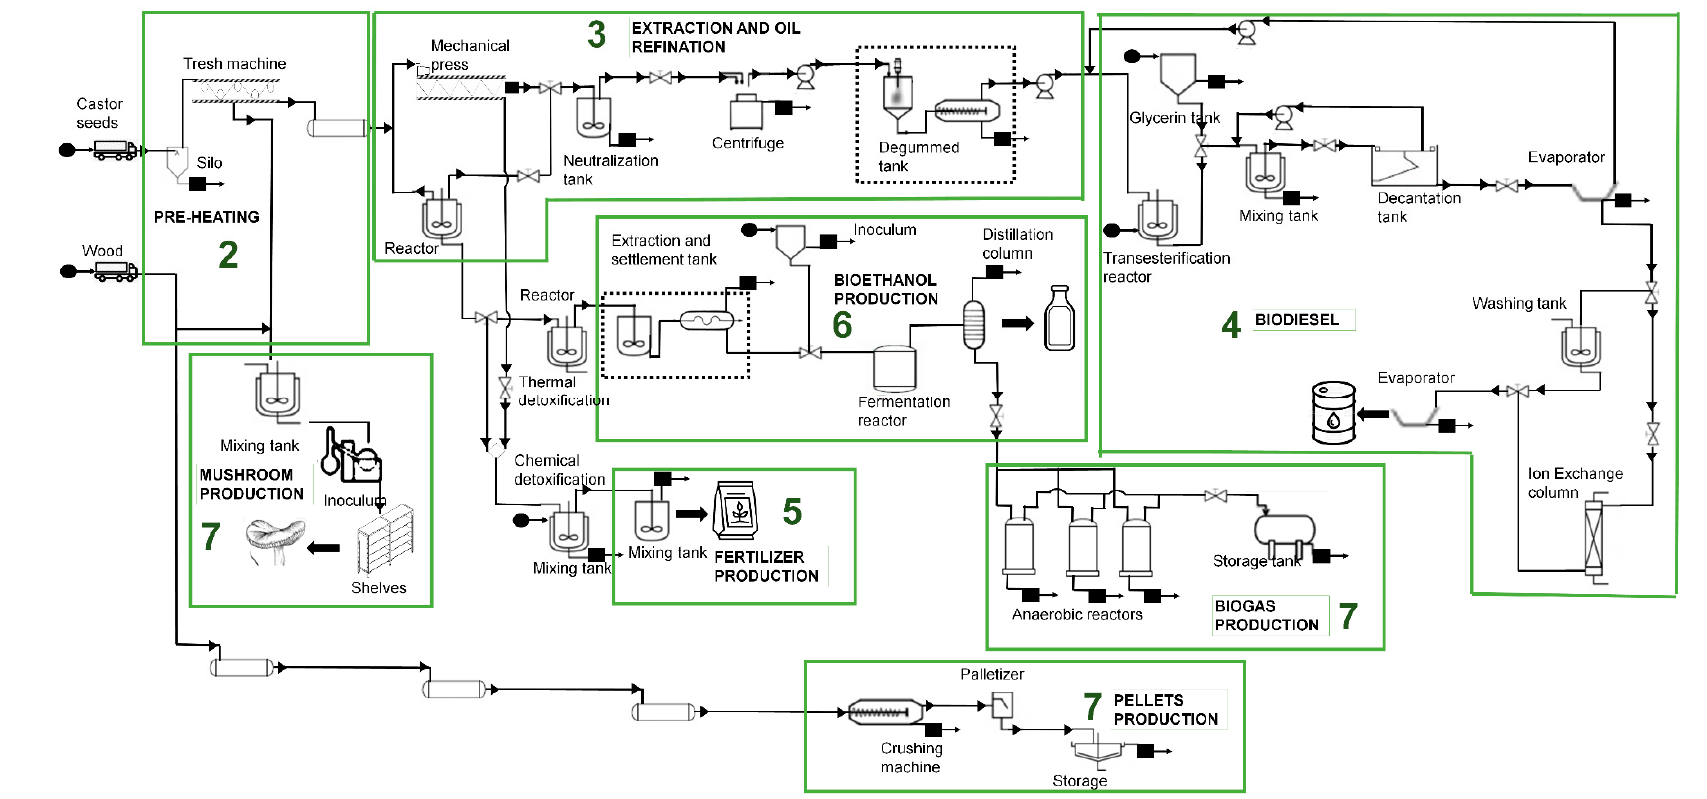
Figure 4. Diagram of equipment required for biodiesel and coproduct processing.